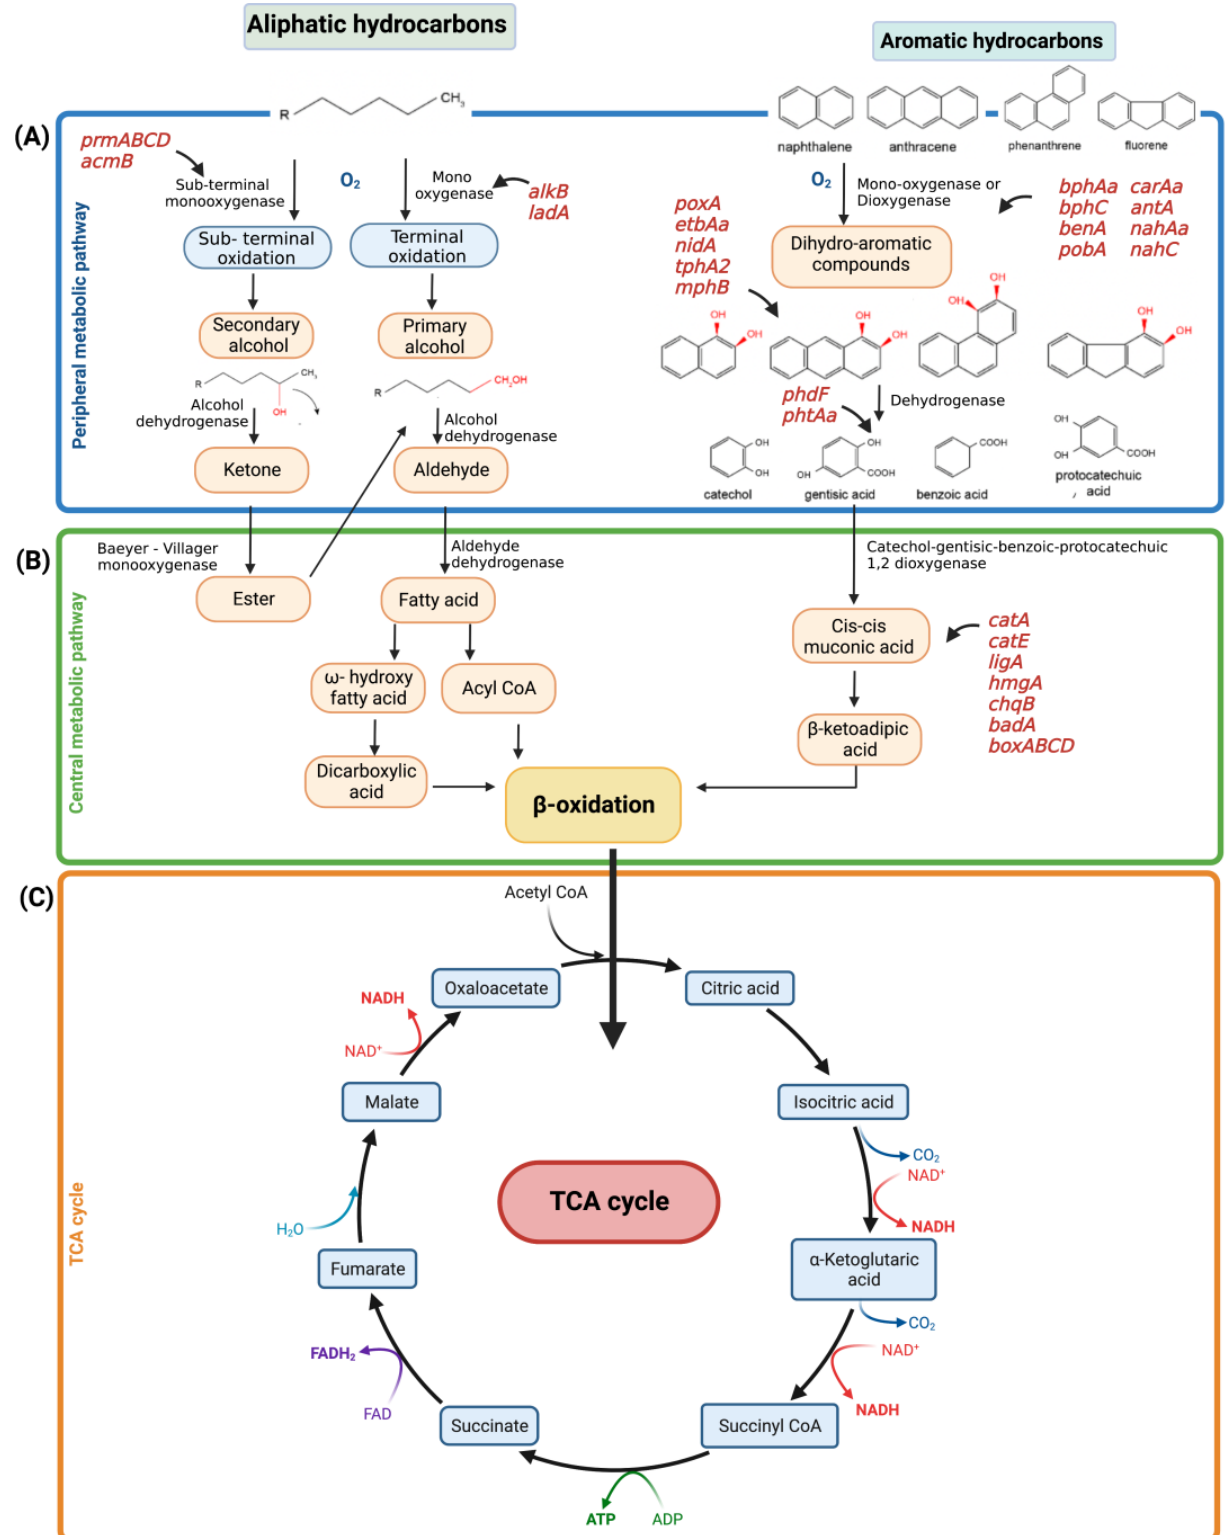
Figure 5. Main bacterial metabolic aerobic pathways of aliphatic and aromatic hydrocarbons. The pathways are subdivided into ( A ) peripheral metabolic pathway (blue rectangle), ( B ) central metabolic pathway (green rectangle); the genes encoding for enzymes involved in A and B metabolism are reported in red; ( C ) Krebs cycle: TCA cycle (orange rectangle).